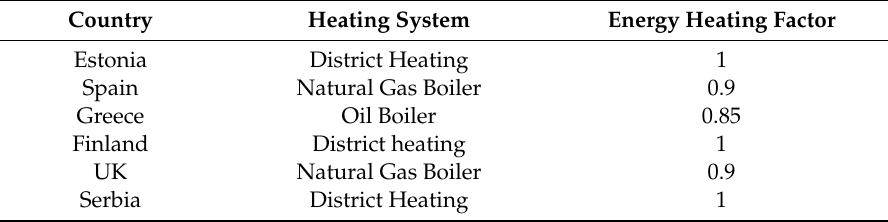
Table 3. Summary table for the energy heating factor considered per technology. Country Heating